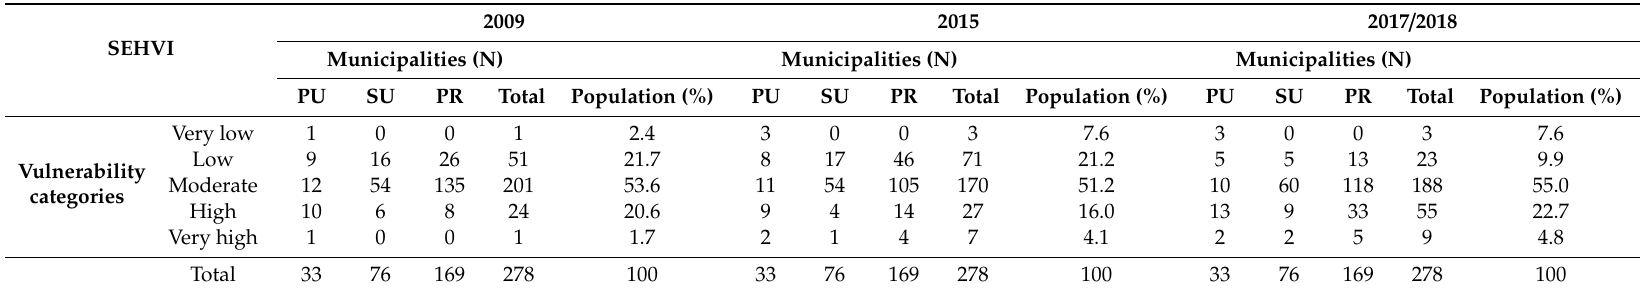
Table 5. Distribution of mainland municipalities number, according to population density (predominantly urban (PU), semi-urban (SU), predominantly rural (PR)) and their corresponding share of population for each year of analysis. Results are grouped by vulnerability categories defined as a function of SEHVI scores (please refer to Figure 3